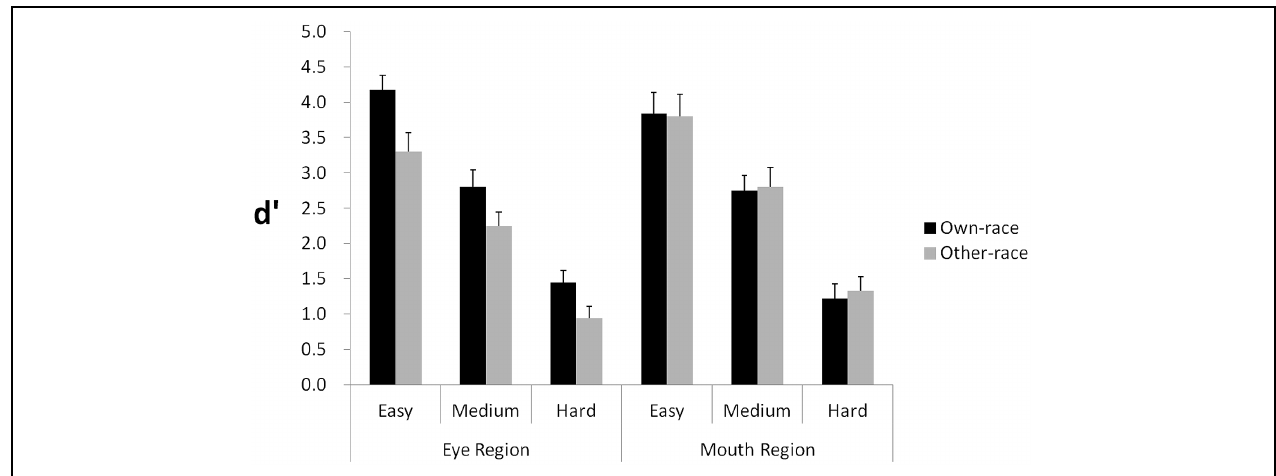
FIGURE 2 | Experiment 1: manipulating the spacing distance of facial features. The graph shows d (cid:3) scores for detecting spacing differences across three levels of change (easy, medium, hard) in the eye and mouth regions, respectively. Error bars represent SEs in each condition.